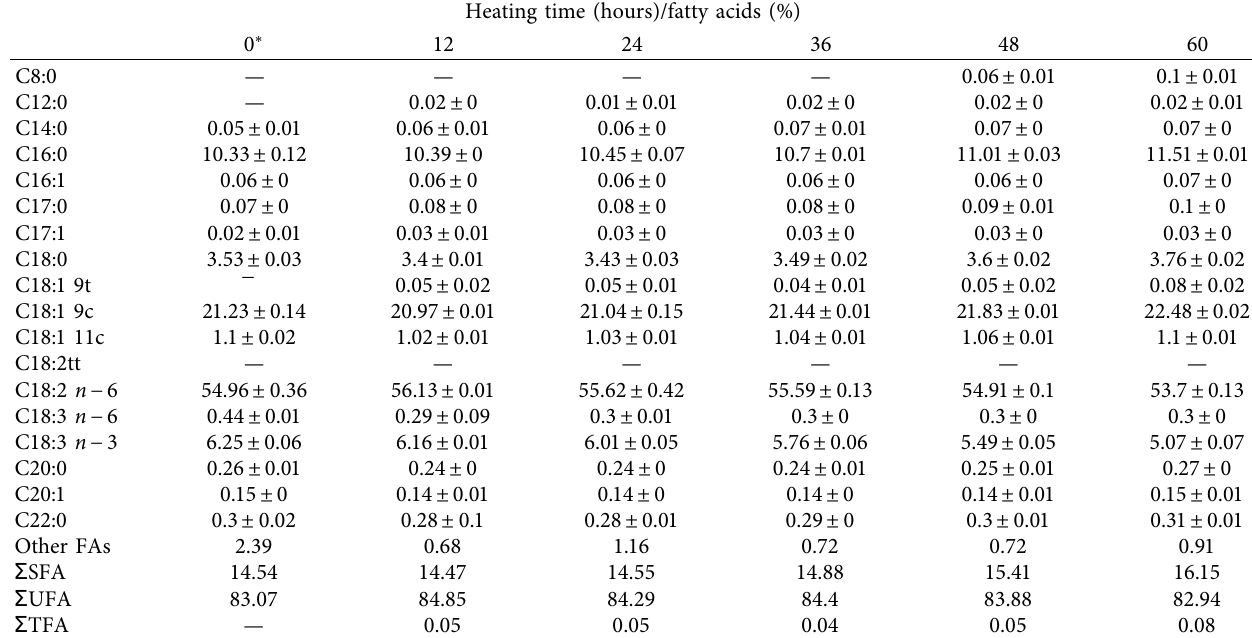
Table 4: Variation of fatty acids of soybean oil under 180 ° C heating temperature at different heating